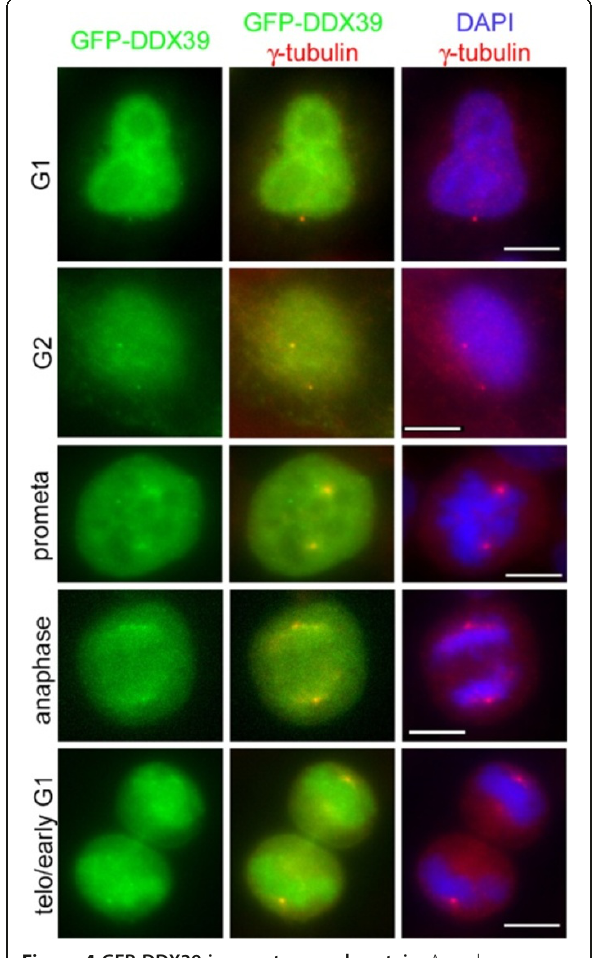
Figure 4 GFP-DDX39 is a centrosomal protein. Asynchronous HeLa cells were transfected with GFP-DDX39 (green), fixed and co-stained with DAPI (blue) and anti- γ -tubulin antibody (red). The cell cycle stages were assigned based on the numbers of γ -tubulin foci and DNA morphology. Bar=10 μ